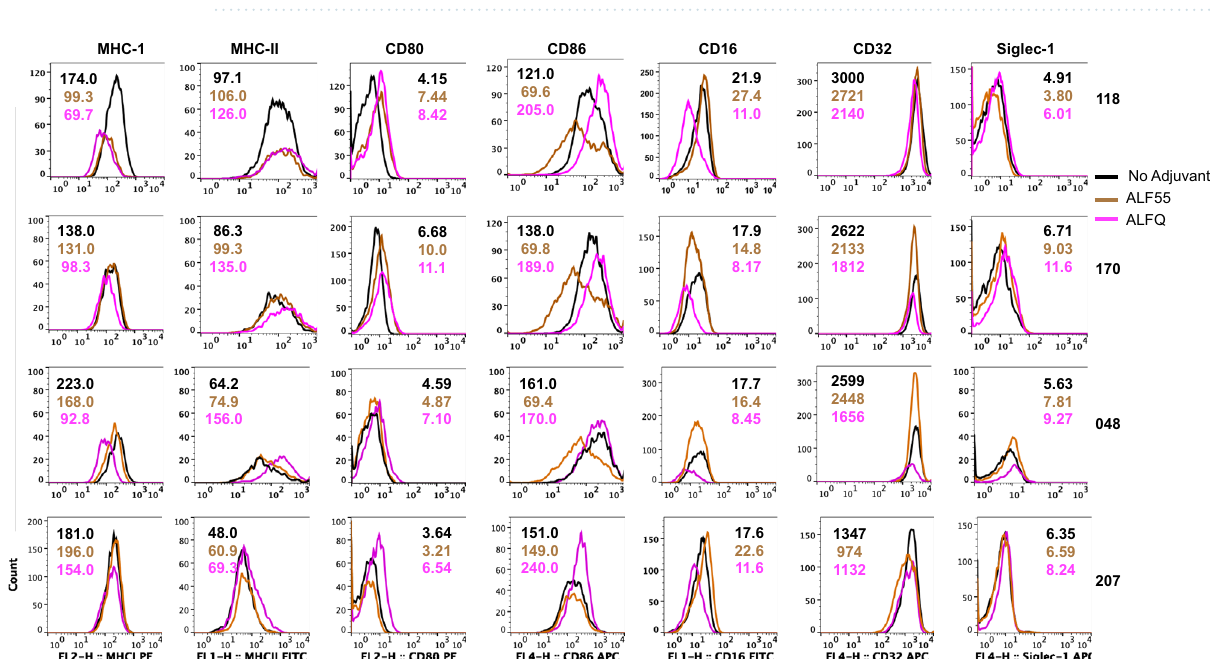
Figure 3. ALFQ induces a higher proinflammatory cytokine response. Primary human monocytes were differentiated into MDM following in vitro culture with M-CSF media. At day 4 post-culture, the cells were treated with ALF55 or ALFQ for 24 h. Untreated MDM cultures served as controls. Supernatants were harvested, clarified, and assayed for the presence of cytokines and chemokines using a custom-made U-Plex electrochemiluminescent immunoassay. Cytokine profiles were visualized as radar plots and show the increase (fold change) in cytokine levels induced by ALF55 (brown) or ALFQ (magenta) compared to unstimulated cultures. Data for each cytokine are averages of three independent experiments. Spokes represent the various cytokines tested; the origin of the plot is the baseline value of the respective cytokine in the unstimulated cultures. * p < 0.05, two-tailed Student t-test.